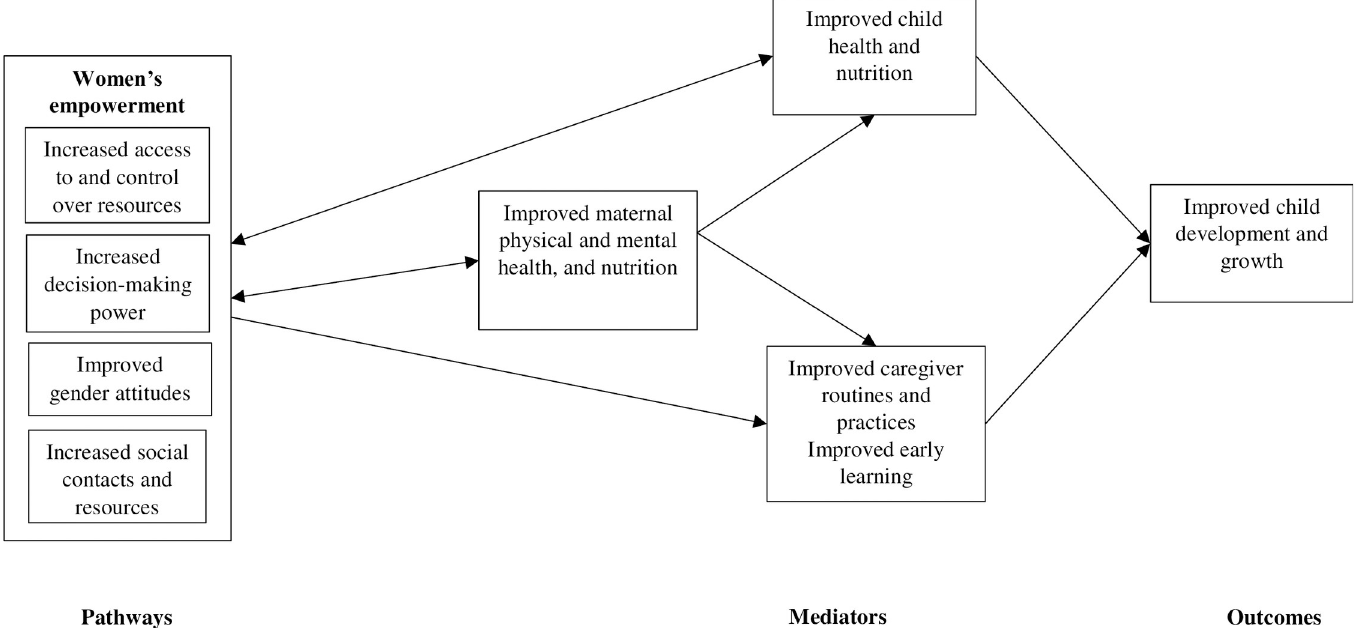
Fig 1. Pathways linking women’s empowerment and early childhood development and growth. One-directional arrows represent 1-way relationships between women’s empowerment, mediators, and outcomes. Bidirectional arrows represent 2-way or interactive relationships between women’s empowerment and women’s and children’s